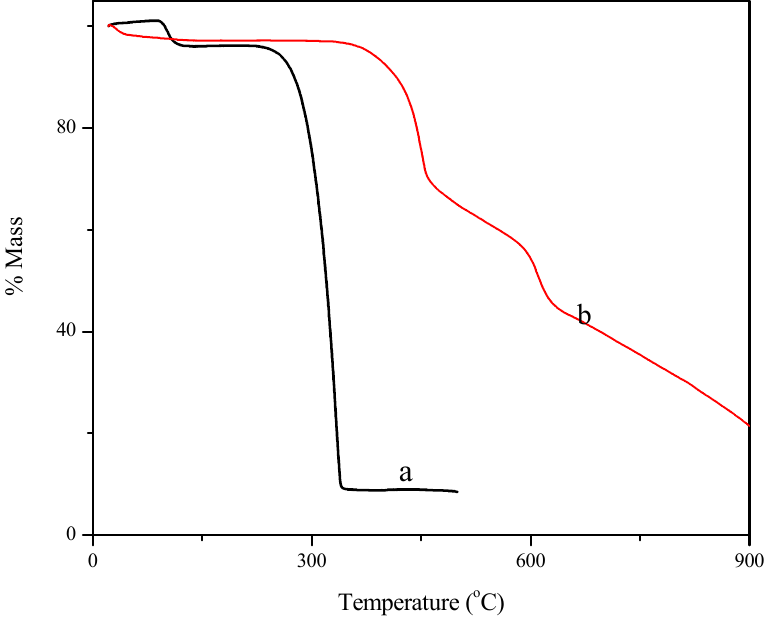
Figure 2. Thermogravimetric curves of 3,7-dihydroxyflavone ( a ) and the complex [Cr(C 15 H 9 O 4 ) 3 ]·3H 2 O ( b ) in N 2 flow.